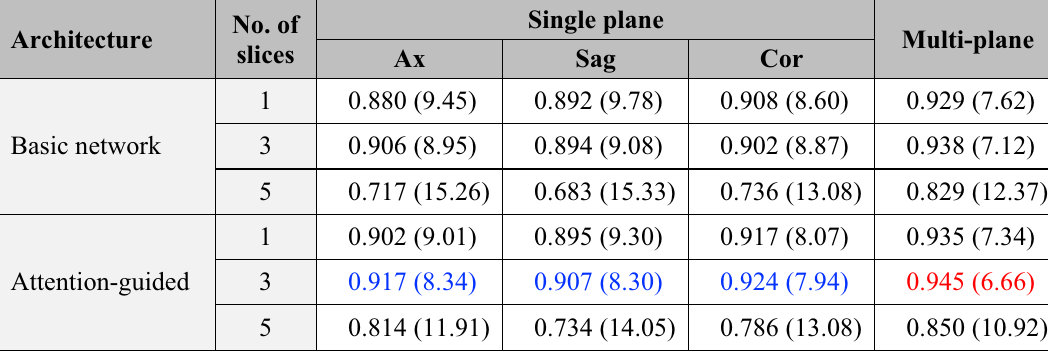
Table 1. R 2 score and mean absolute error performance across model architectures. R 2 scores and corresponding MAE (days) are shown for each model architecture. ResNet-50 was used as the backbone. The Basic Network analyzes the entire image as input without attention masking. For each column, the best performance based on R 2 score and mean absolute error is colored in blue. The highest performing architecture across all tested permutations is in